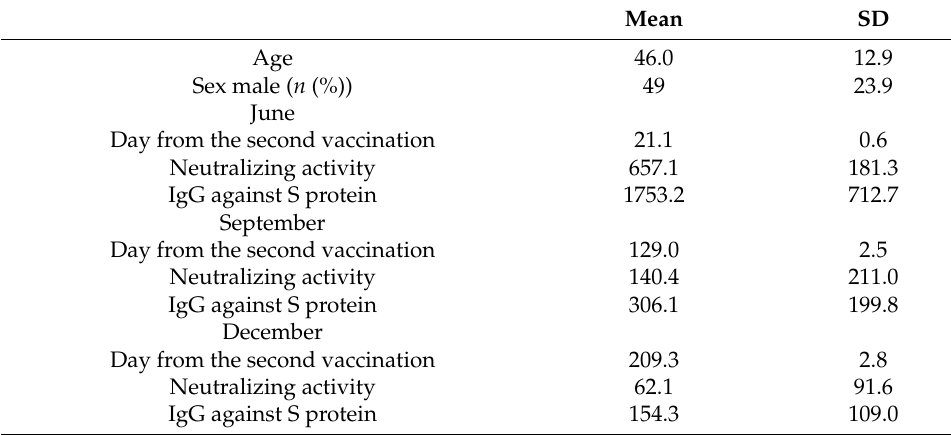
Table 1. Participant characteristics (N =